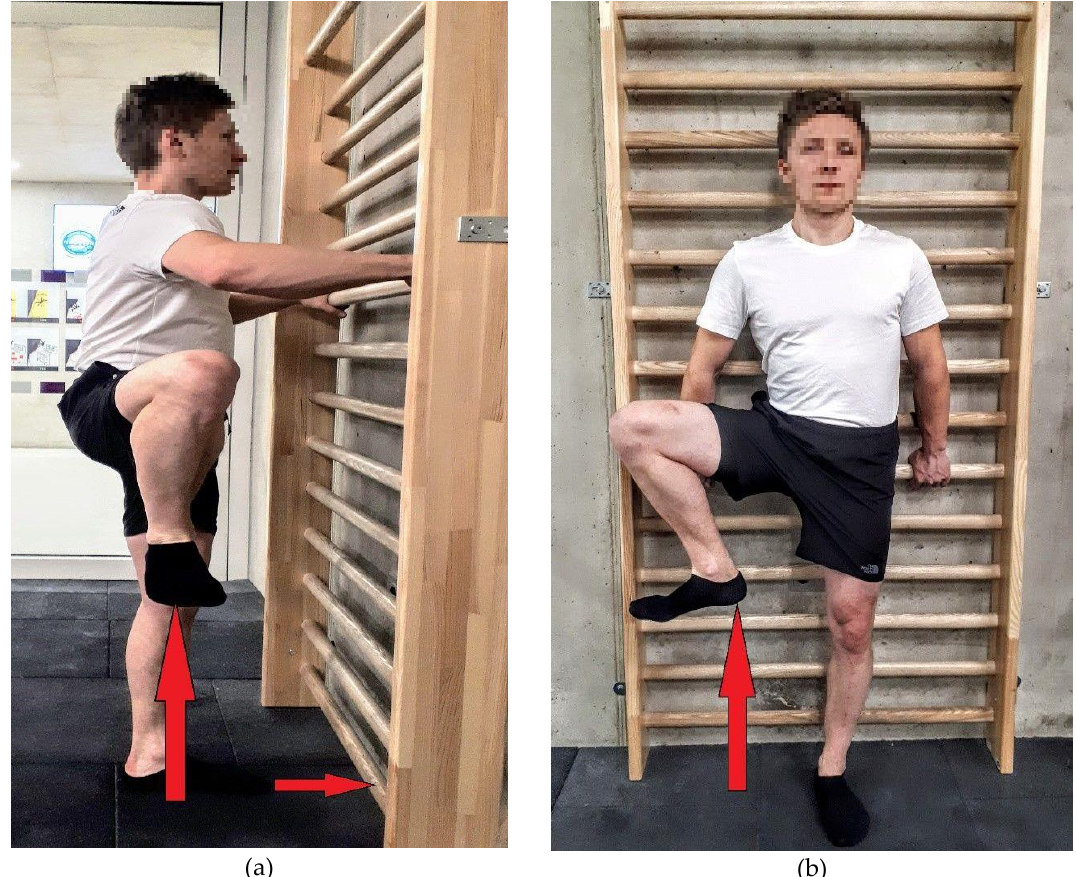
Figure 1. Tests for evaluation of hip joint mobility: ( a ) Grant test modified by Draper et al. (2009); ( b ) Author’s Draga